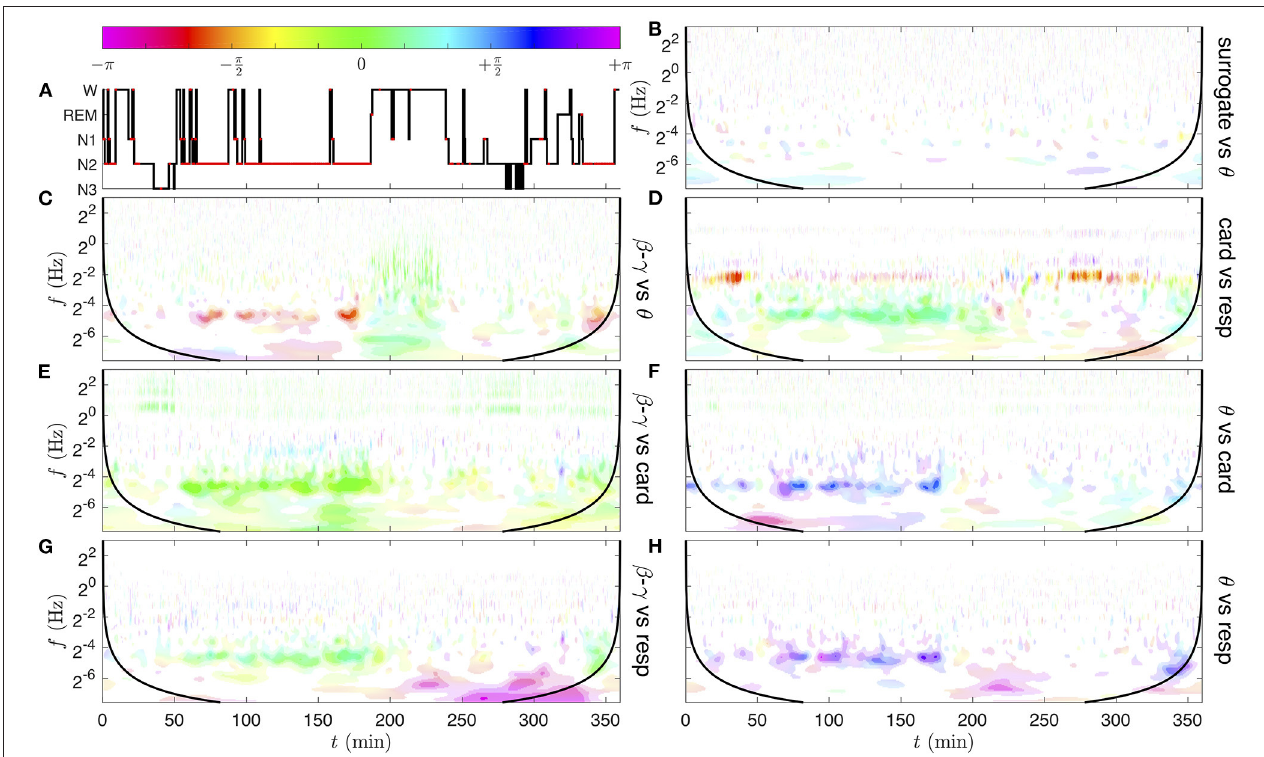
FIGURE 10 | Time-frequency coherence analysis of the physiological rate signals pairs, obtained from their CWTs represented in Figure 8 . In the following, the Q , n ), the EEG band signals are the log-amplitude modulations estimated as coherence of signal x vs. signal y corresponds to the quantity γ xy ( f , t ; cardiac and respiratory rates are the frequency modulations estimated from the ECG and respiration signals as K I . (A) Hypnogram; the red dots corresponds to annotated events of obstructive apnea with arousal. (B) Band θ surrogate (phase-randomized signal) vs. θ . This control coherence illustrates the level of significance of γ vs. θ band, (D) cardiac vs. respiratory rate, (E) β γ band vs. cardiac rate, (F) θ band vs. cardiac rate. (G) β the spurious coherence. (C) β − − γ xy respiratory rate. (H) θ band vs. respiratory rate. The ranges of coherence moduli for the color saturation coding are delimited by the lower thresholds | | γ (10 − 1 ) 0.46, γ (10 − 3 ) 0.71, 0.8, 0.9. The quality factor of the Grossmann wavelet is Q 5 and the Gaussian time-smoothing parameter is n ≈ ≈ = coherence image, a black line materializes a distance n δ t from the initial and final times, beyond which border effects are